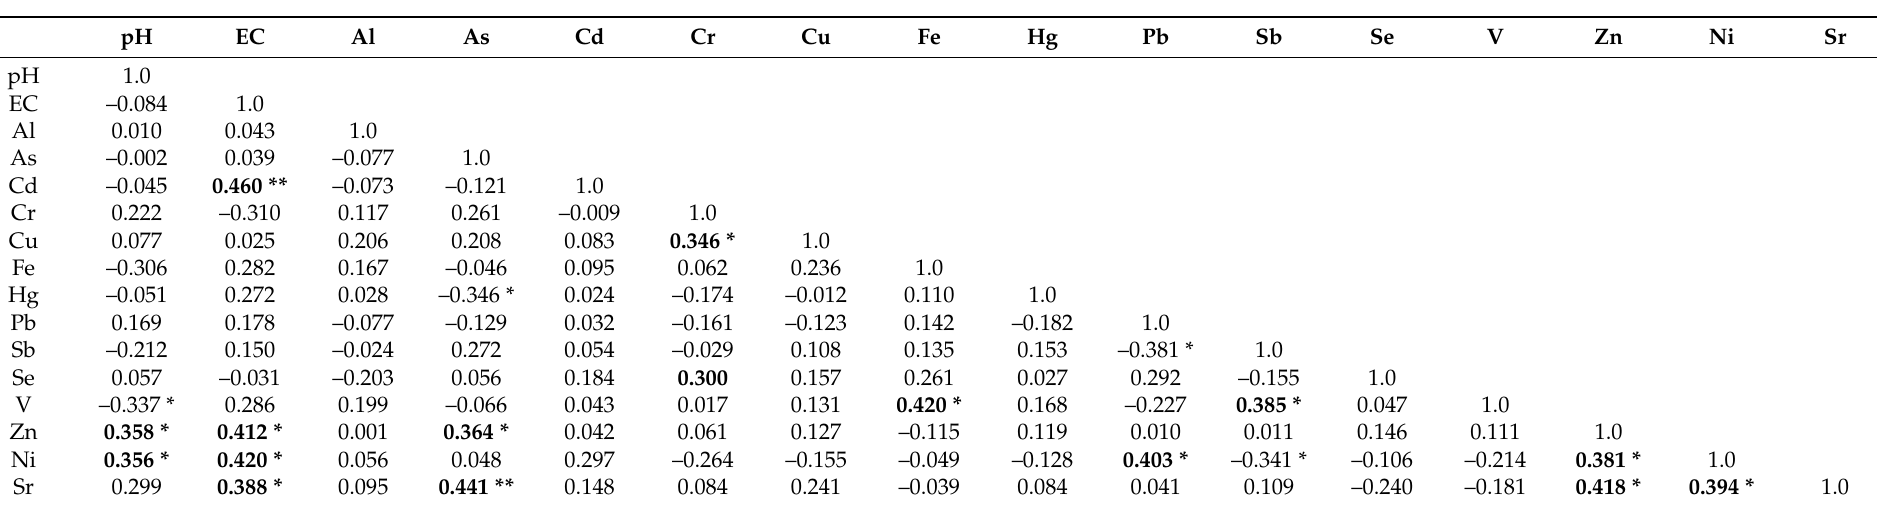
Table 4. Correlation matrix of the investigated